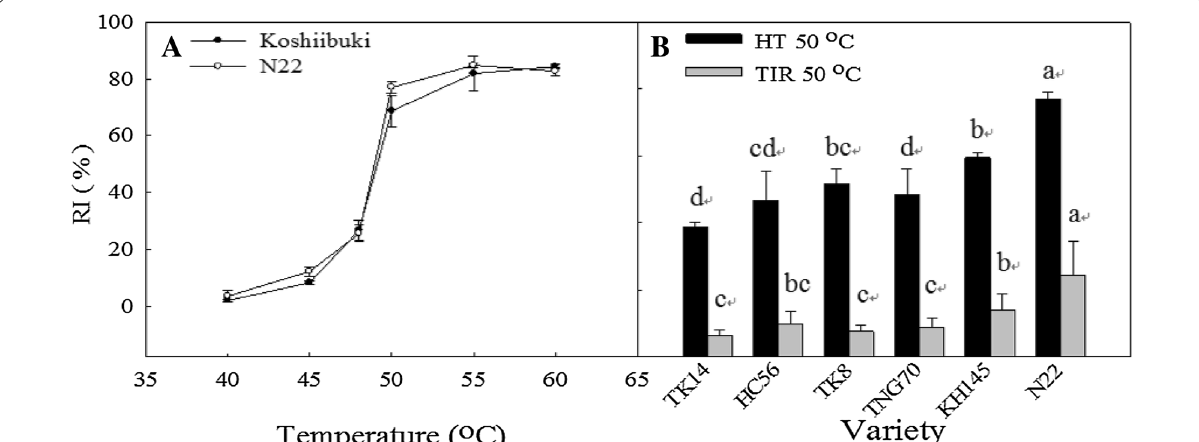
Fig. 8 Relative injury (RI) values of rice seedlings under different temperature treatments ( a ) and the effect of TIR50 and HT50 on the RI (%) of rice seedlings ( b ); different letters above the same color bars indicate a significant difference at the 0.05